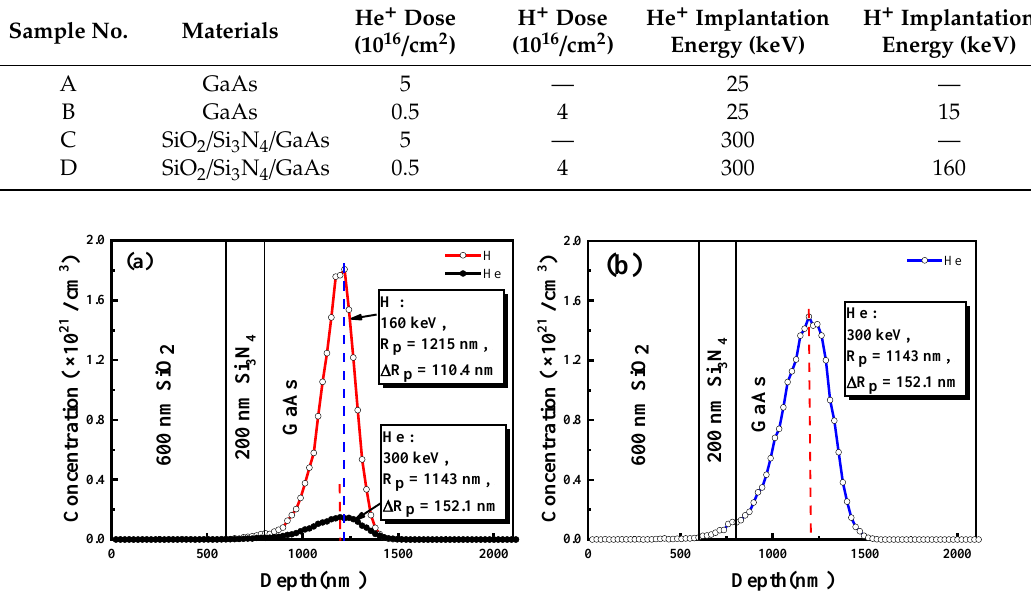
Figure 1. Ion concentration as a function of implantation depth in Samples C ( b ) and D ( a ).